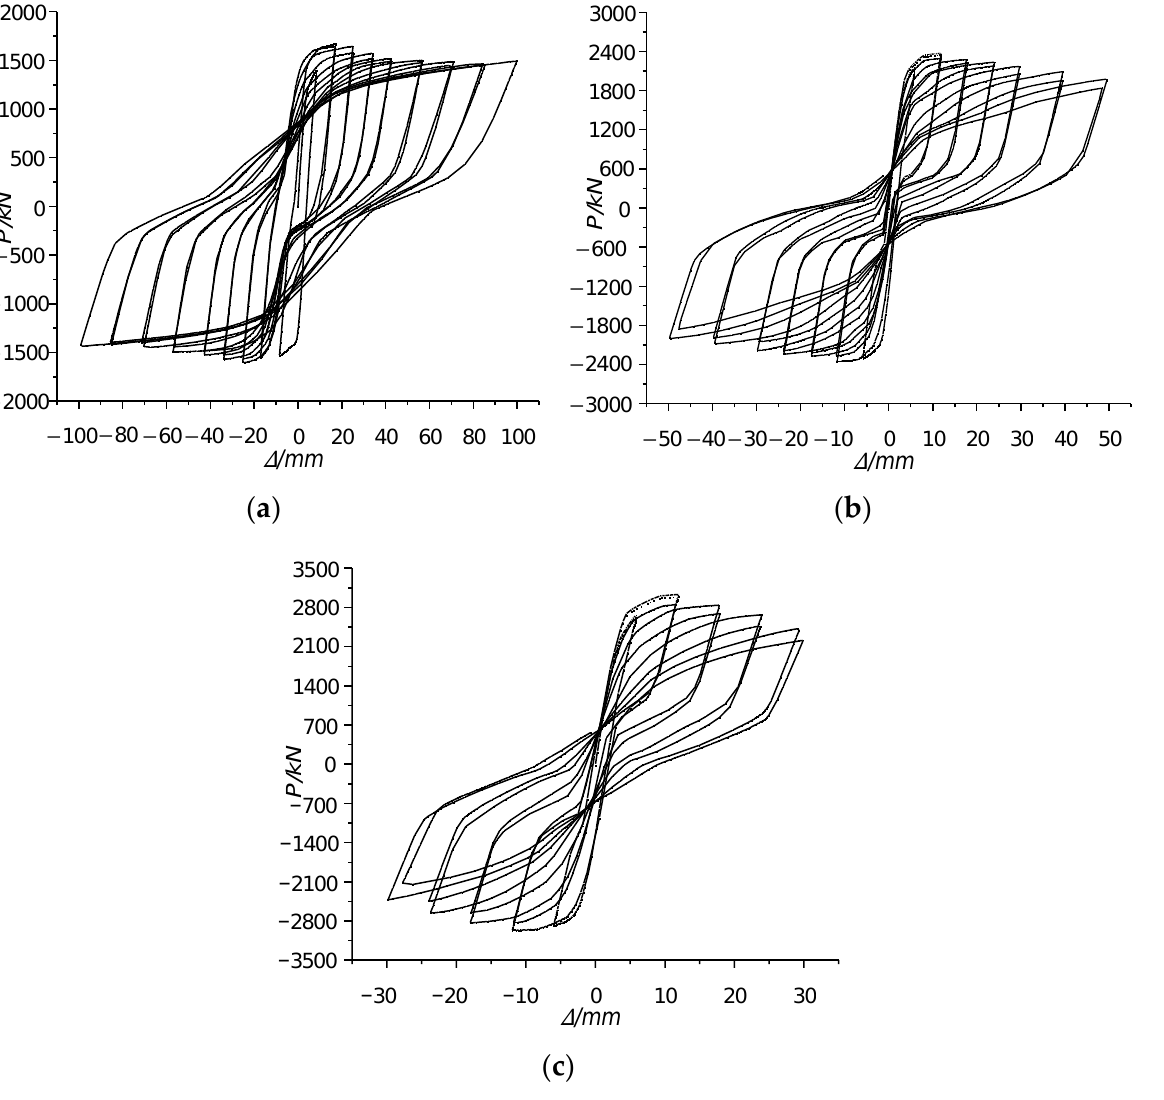
Figure 9. Hysteretic loops. ( a ) GJ-1; ( b ) GJ-2; ( c ) GJ-3.